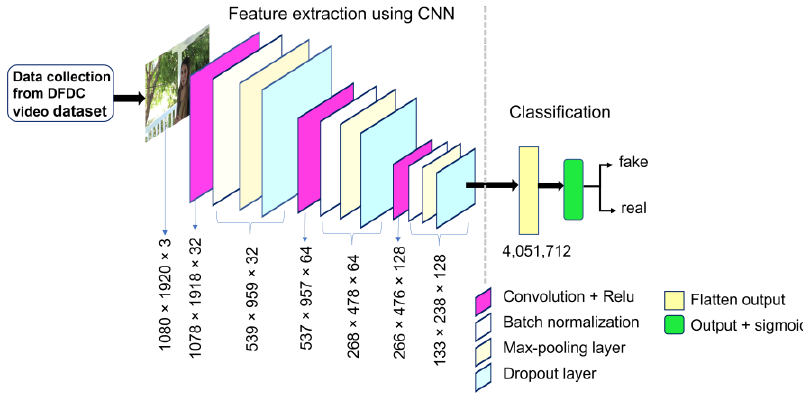
Figure 3. Proposed CNN architecture of Model-B for detecting deepfake images.